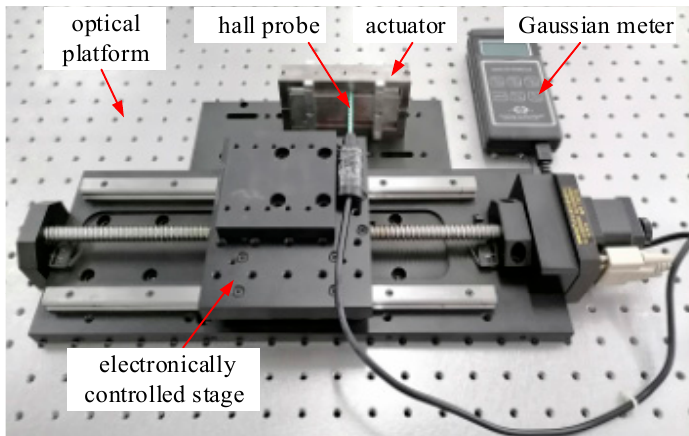
Figure 9. Experimental setup for the magnetic flux density test.